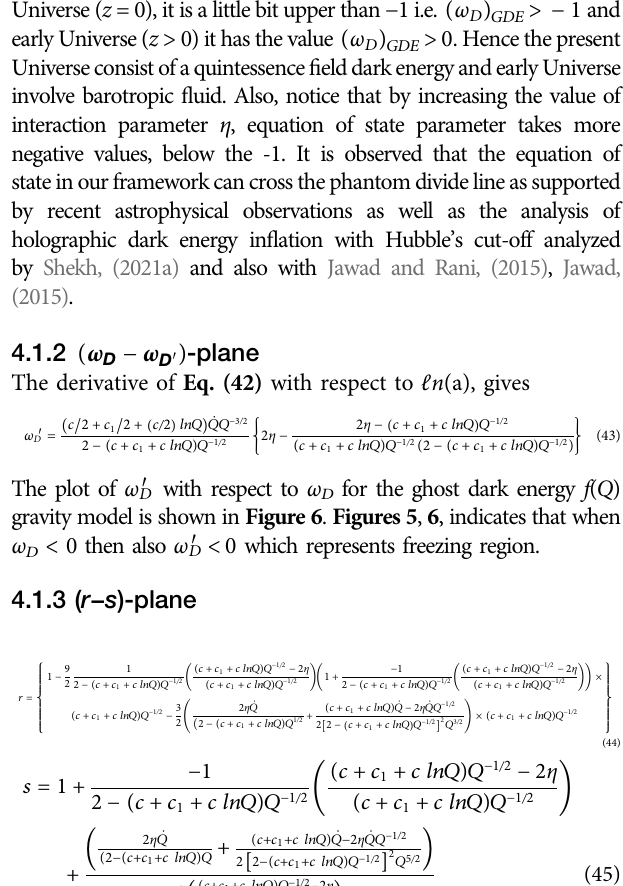
Frontiers in Astronomy and Space Sciences |